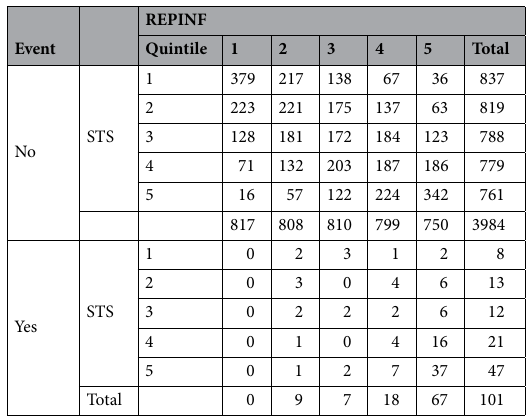
Table 3. Reclassification data table with quintiles for net reclassification improvement (NRI). REPINF, REPLICCAR II, São Paulo, Brazil, 2017–2019.